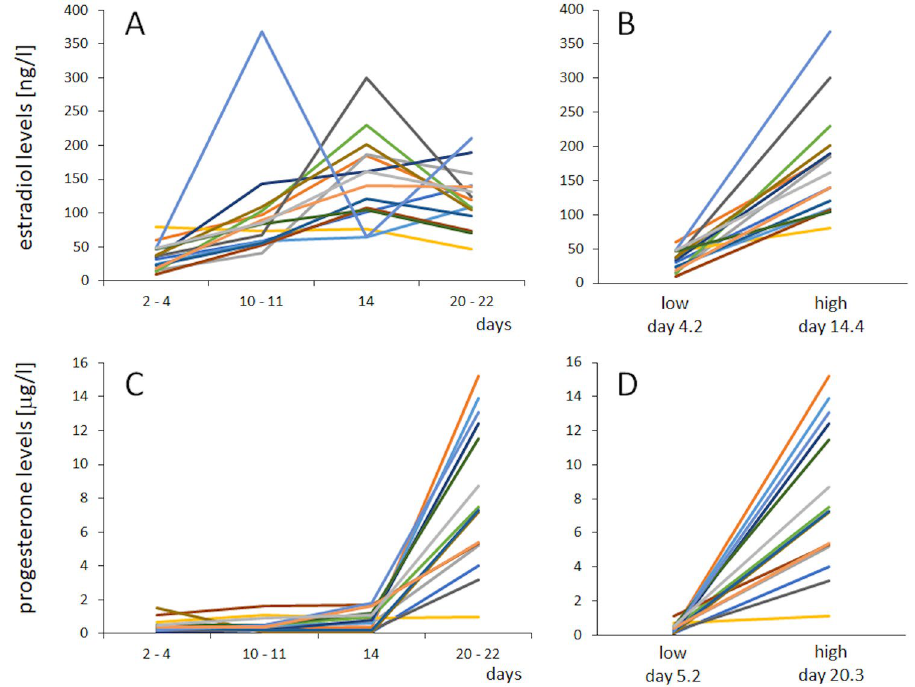
Figure 3. Individual hormone levels. Hormone levels of estradiol ( A ) and progesterone ( C ) at the testing time points (day 2–4, day 10–11, day 14, and day 20–22), and at the individual lowest and highest levels of estradiol ( B ) and progesterone ( D ).